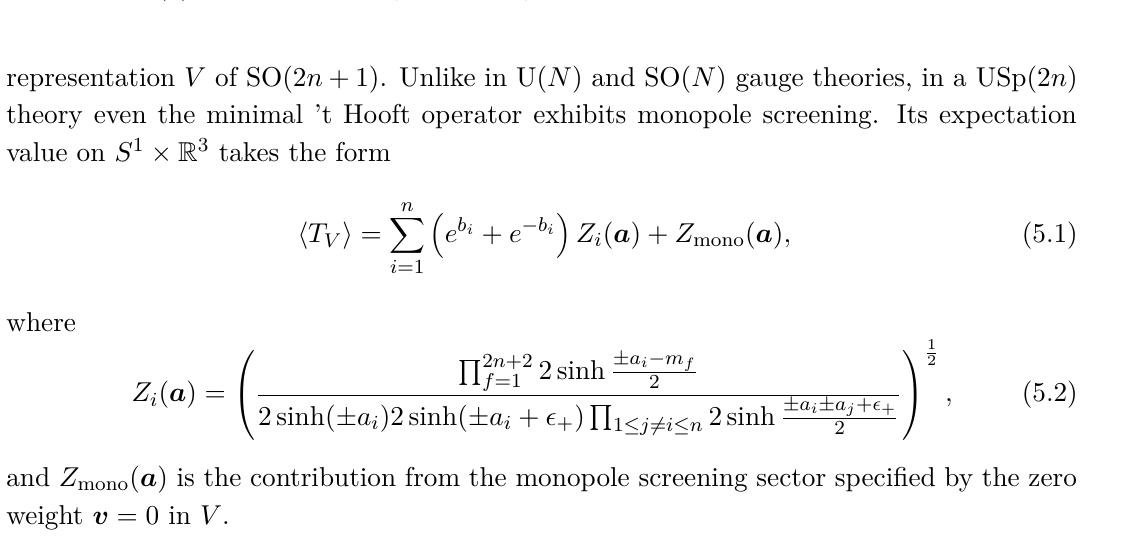
Figure 19. (a): the brane configuration for the monopole screening contribution to the v = 0 sector in T V . (b): the corresponding quiver